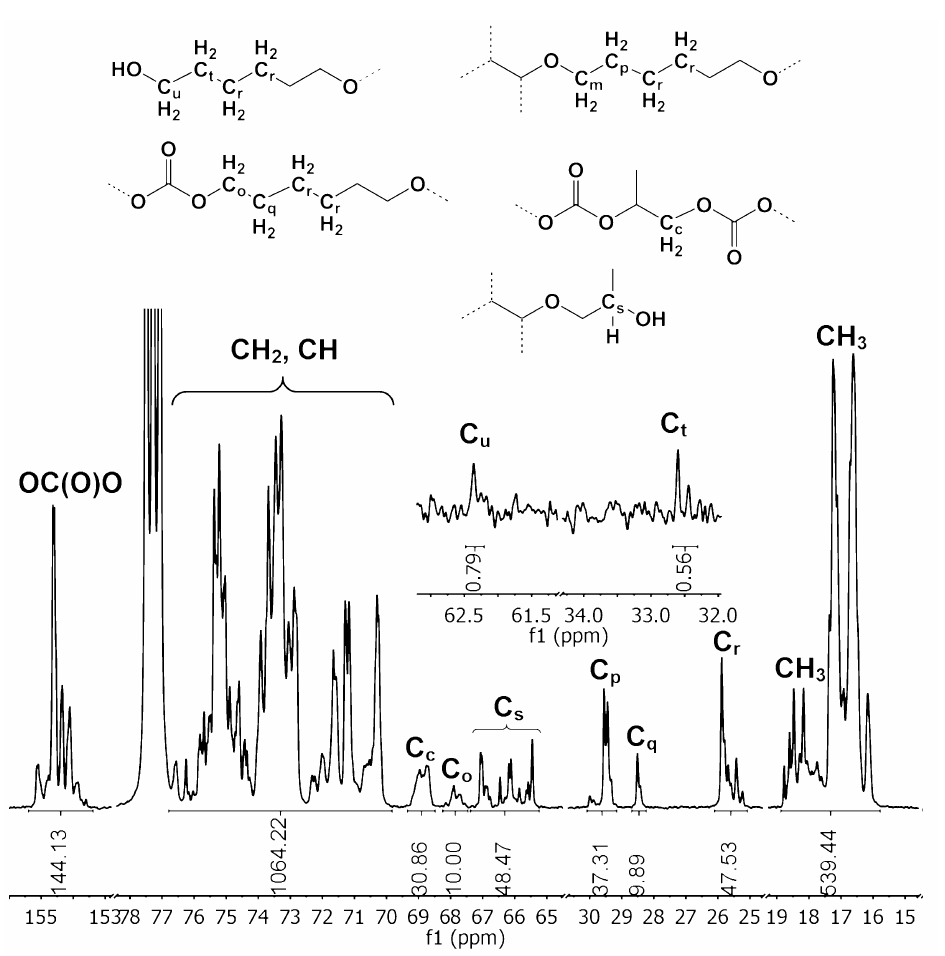
Figure 10. 13 NMR spectrum of OECHD. Figure 10. 13 C NMR spectrum of